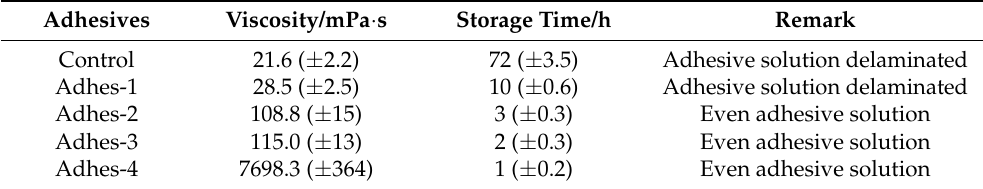
Table 2. Viscosity and storage time of Camellia oleifera cake-protein